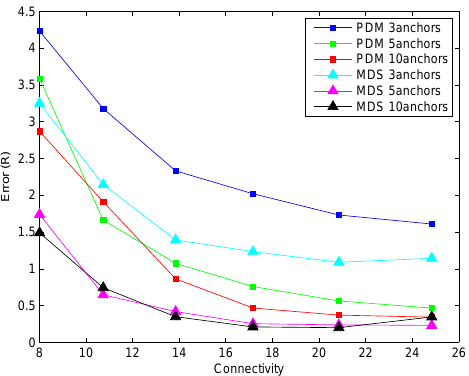
Figure 3 . 200-node networks, clustered anchors, measurement